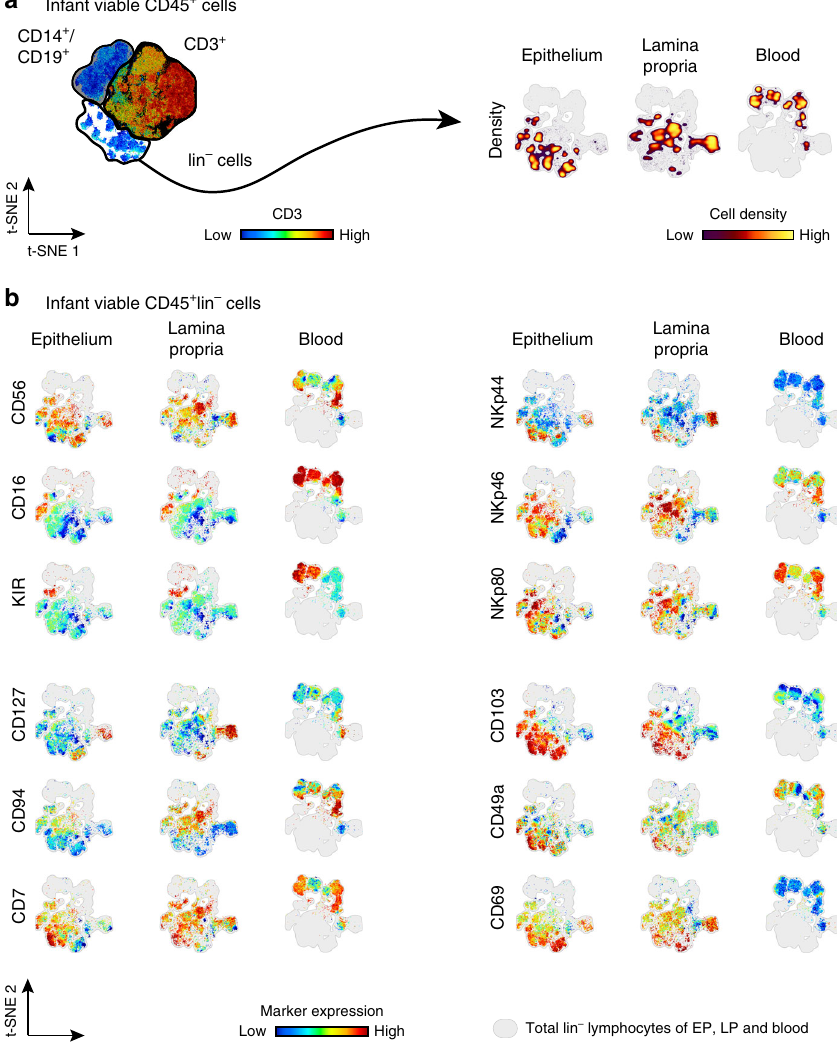
Fig. 1 Hallmarks of ILCs by infant blood and intestinal CD45 + lin − cells. a viSNE plot of fl ow cytometric analysis of viable CD45 + cells showing separate clustering by tissue of origin: epithelium (EP), lamina propria (LP), and blood (B). b Individual representation of hallmarks of ILCs (CD56, CD16, KIR, CD127, CD94, CD7, NKp44, NKp46, NKp80, CD103, CD49a, and CD69) using viSNE algorithm of fl ow cytometric data of lin − (CD14 − CD19 − CD3 − ) cells for EP, LP, and blood samples. Expression is shown by color coding in relative intensity. viSNE plots have been calculated from concatenated FCS fi les gated on viable CD45 + lymphocytes from epithelium, lamina propria, and blood of matched donors ( N = 4, iterations = 7500 perplexity = 100, KL divergence =